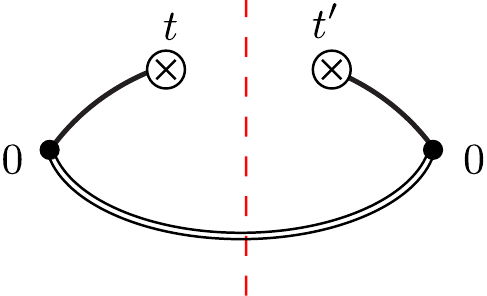
Figure 1 . Graphical representation of the chromoelectric fields and Wilson lines in the integrand of eq. (3.15). The symbols ⊗ represent insertions of chromoelectric fields at the times t and t 0 , and the filled circles represent the spacetime origin. Solid lines are Schwinger lines, double lines are gauge-completion Wilson lines in the ‘ direction, and the dashed line is the